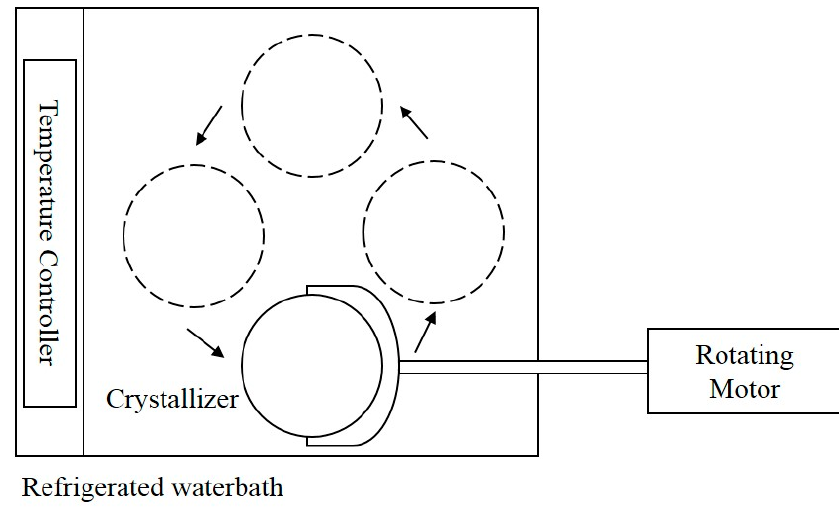
Figure 1. Circular motion of cylindrical crystallizer in refrigerated bath.